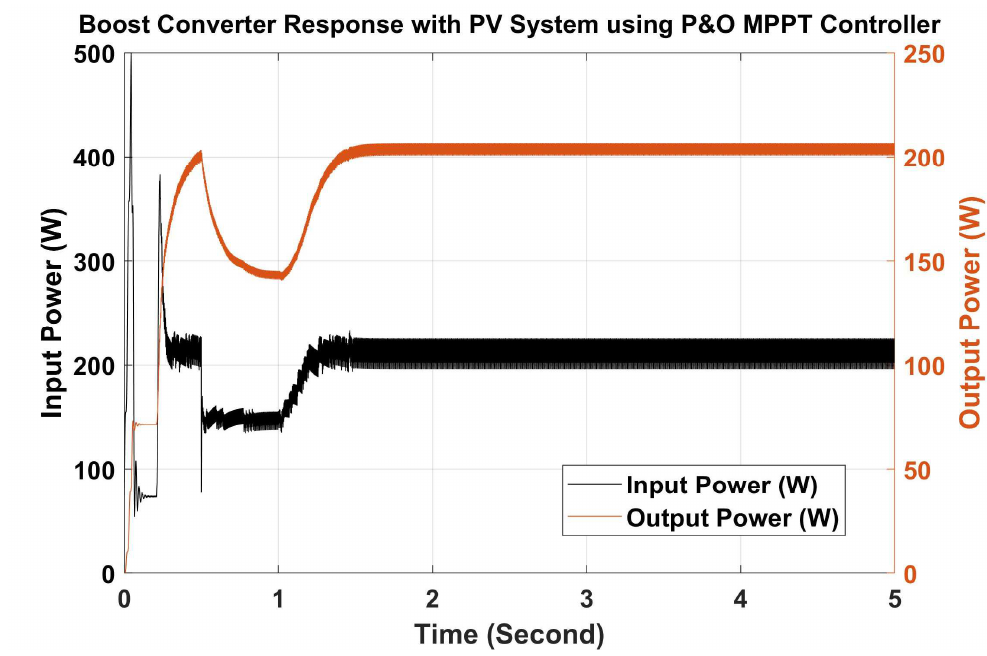
Figure 5. Input and Output Power of Boost Converter with PV System and P-&-O MPPT Controller.